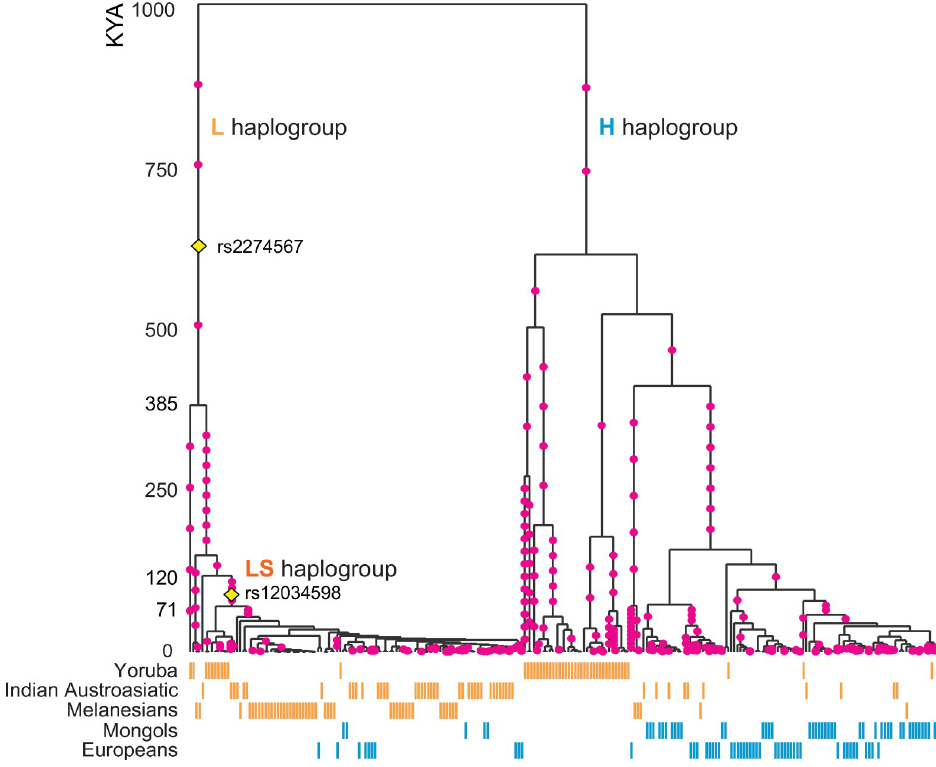
Fig 3. A coalescent tree of the CR1 locus. For the sub-region of the gene locus (intron 20 to intron 27: ~16.7 kb), a coalescent tree was estimated by RELATE [39]. The tree is one estimate out of the 100 replicates, as described in Method. The pink dots on the tree branches represent mutations (SNPs) assigned to the lineages of the tree. Vertical and short bars below the tree correspond to the tips of the trees (each haplotype) of five population groups used to construct the tree. The yellow diamonds indicate the locations of rs2274567 exon 22 SNP and rs12034598 intron 24 SNP on the tree. We detected two distinct haplogroups in the tree, defined by rs2274567, and designated as the L and H haplogroups. The L haplogroup is more frequent in Indian Austroasiatic and Melanesian populations than in Mongols and Europeans. The LS haplogroup is defined by two SNPs, rs2274567 and rs12034598.